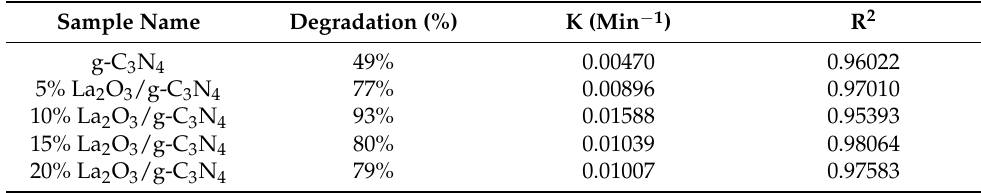
Table 3. Photocatalytic results of all